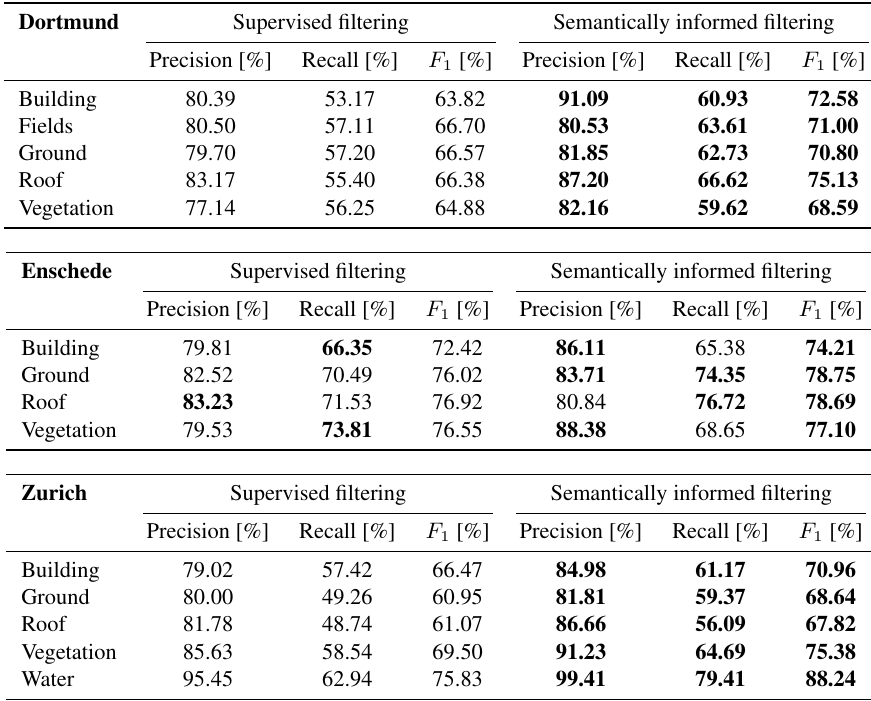
Table 2: Quantitative results per semantic class (average numbers after 6-fold cross-validation) of the supervised, non-semantic filtering approach and the semantically informed filtering